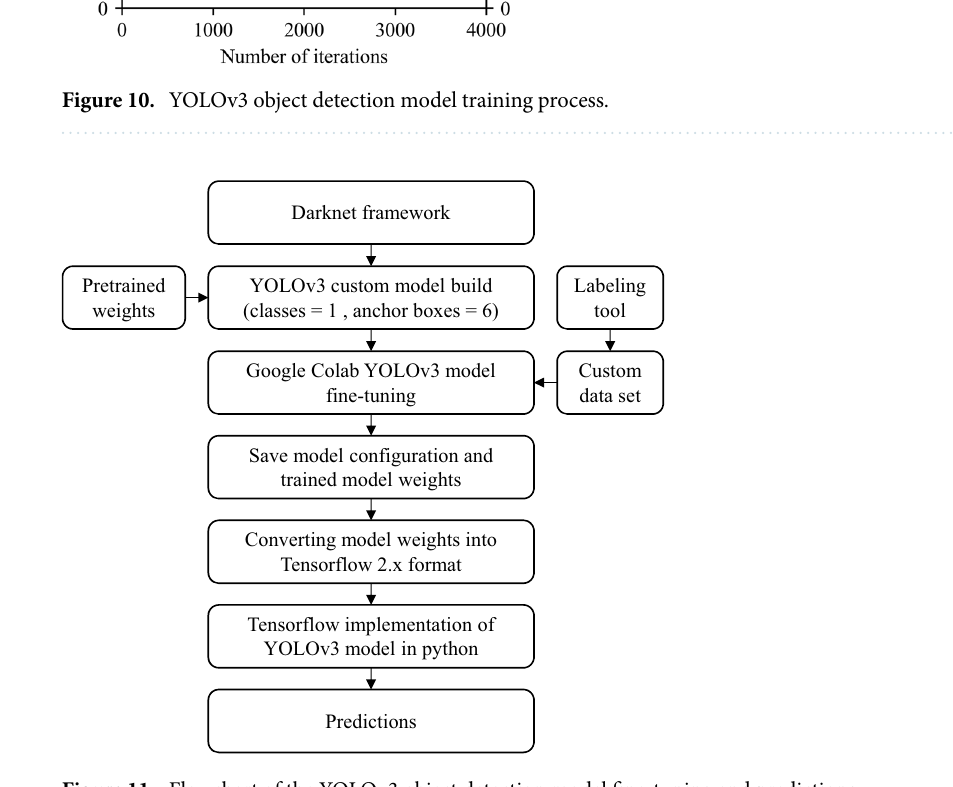
Figure 11. Flowchart of the YOLOv3 object detection model fine-tuning and